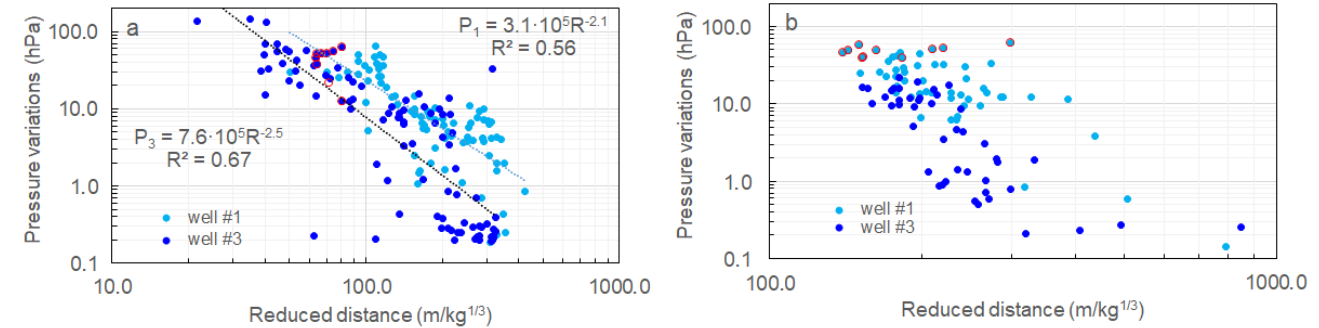
Figure 6. Pore pressure variations in the system reservoir-well versus reduced distance for explosions in the mine ( a ) and in the quarry ( b ) (red circles denote explosions after which postseismic lowering of water level was traced).